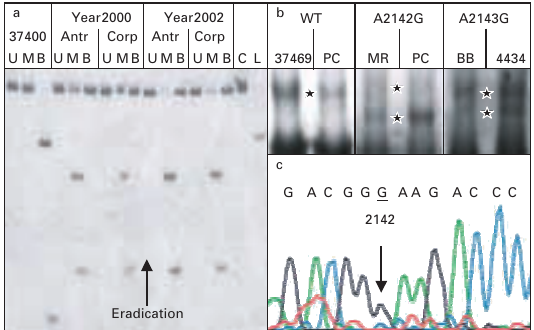
strand, and to use the line probe kit assay for con- firmation of positive results for all further patients. In 19 of these 21 patients (90%; 95%-confidence interval: 69.6–98.8%) the H. pylori strain displayed a point mutation of the genomic 23s rRNA at po- sition 2142/43 after therapy. The remaining two using a polyclonal anti- H. pylori antibody (DAKO- Cytomation) and PCR amplification for absence of microbes. 15 of these 16 patients were eradicated with a triple therapy regimen, always including clarithromycin and a PPI. Nine patients obtained in addition amoxicillin, 4 metronidazole and 2 ornidazole. One patient was eradicated only with clarithromycin. In all 16 pre-eradication biopsies H. pylori strains were WT for loci 2142/43 without any minimal mutated moiety (resistance rate 0%; 95%-CI: 0–20.6%). The mutation frequency distribution for the three series is given in table 1. For 13 of the 19 pa- tients with failed eradication and mutated mi- crobes, an available pre-therapy biopsy was also in- vestigated (table 2). A pure WT strain was found in 5 of the 13 patients (38%) and a pure mutant one in 3 (24%). The other 5 patients (38%) harboured a mixture mutant/WT, 3 of them with only a minor mutated moiety. The evolution of the H. pylori population after therapy is also demonstrated on table 2: the already pure mutated strains remained constant post eradication and the mixed mu- tant/WT ones changed to pure mutant. The 5 pure WT ones changed to pure mutant. Interest- ingly, in one patient (Nr. 85) the 2142 A to G mu- tation was completely lost after therapy. In the total